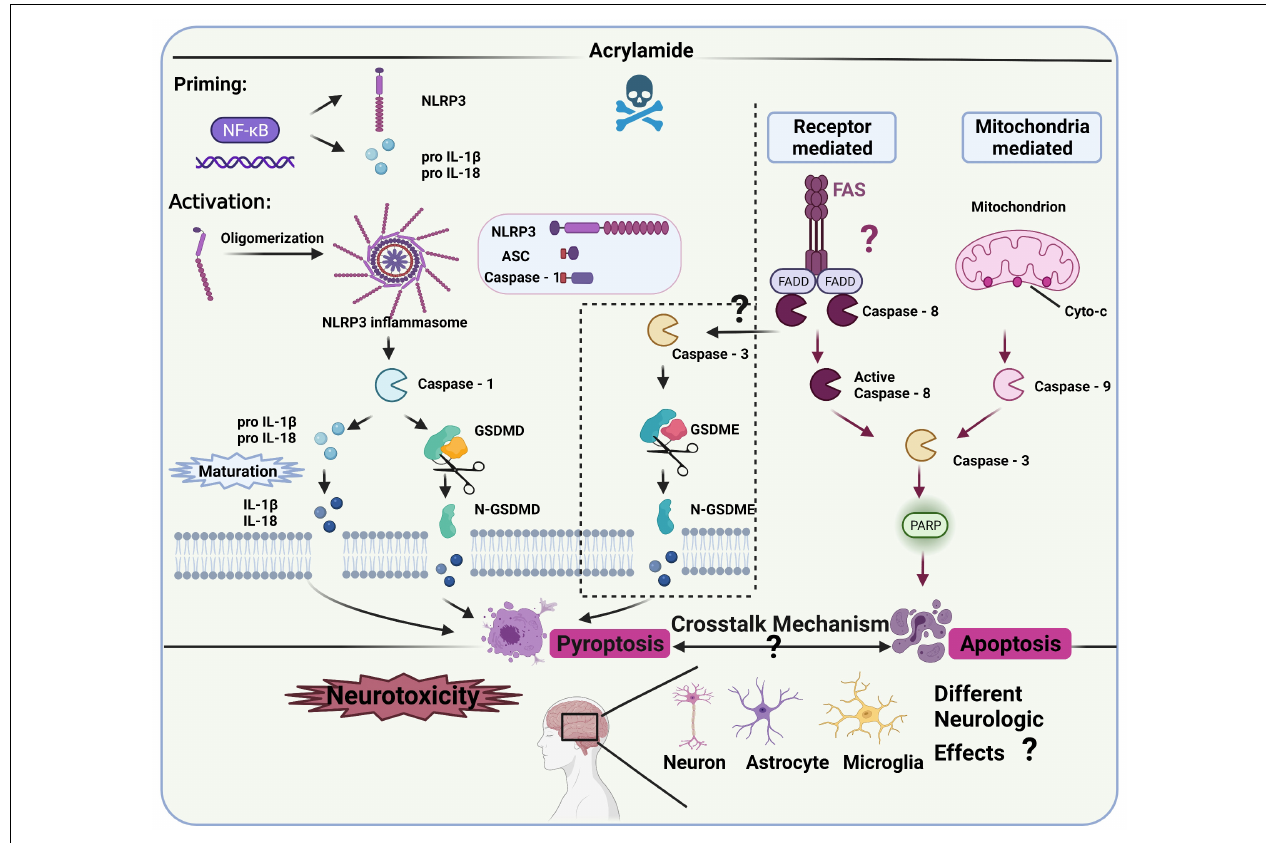
FIGURE 4 | NLRP3 inflammasomes and the related pathway in ACR-induced neurotoxicity.